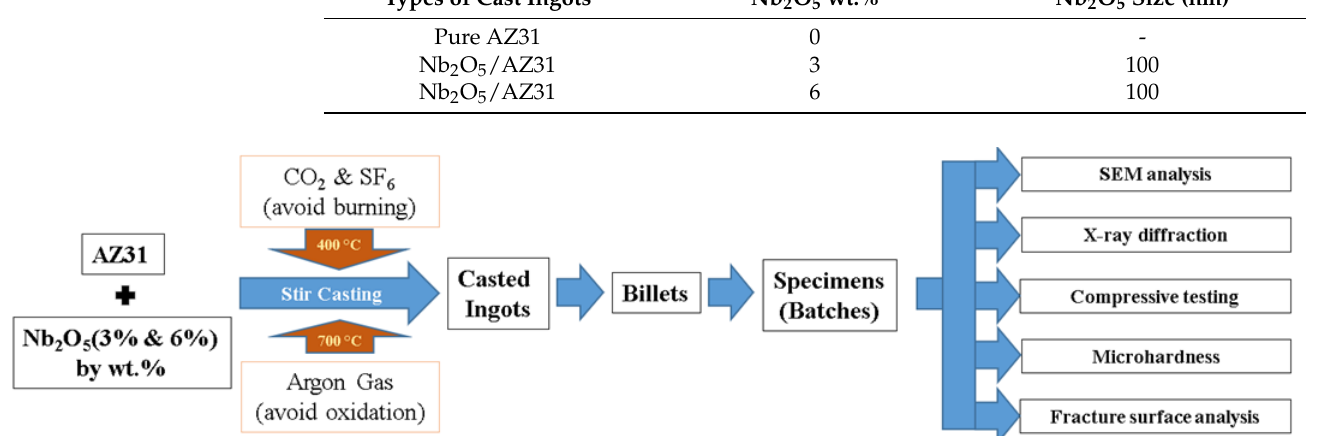
Table 1. Composition of AZ31 and reinforcement. Types of Cast Ingots